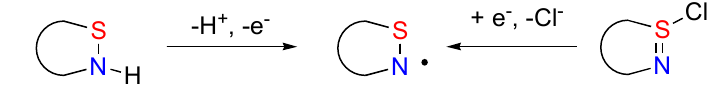
Figure 2 . Two general methods to generate the thioaminyl